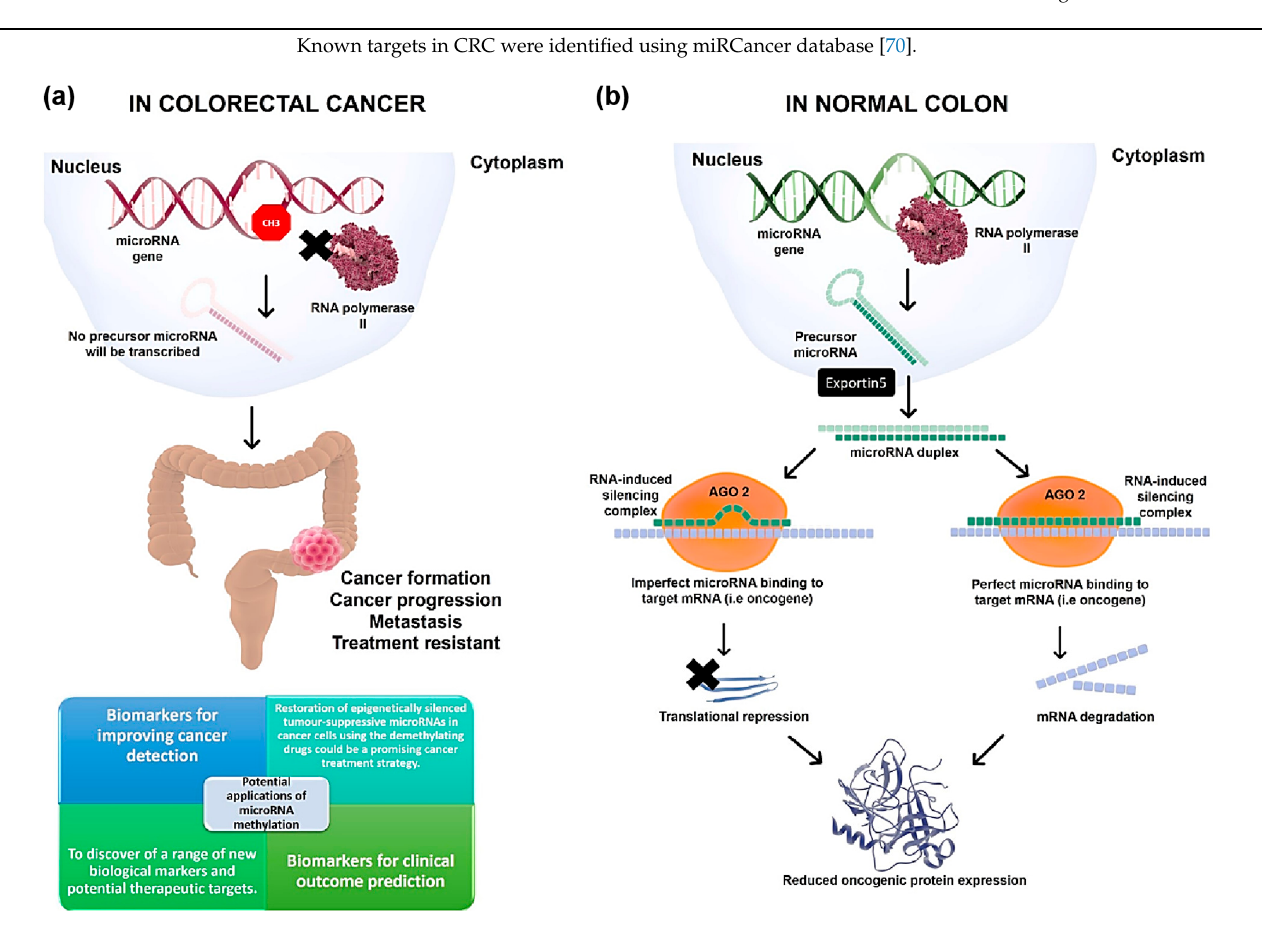
Figure 2. The involvement of methylated microRNA in CRC. ( a ) Simplified illustration of microRNA and its potential involvement in CRC. DNA methylation is a key epigenetic mechanism for silencing RNA polymerase II-transcribed genes [71]. When the microRNA gene is methylated, no precursor microRNA will be transcribed, thus reducing its mature microRNA expression [72]. This in turn could lead to cancer formation, progression, and treatment resistance. ( b ) Simplified illustration of microRNA and its potential involvement and application in normal colon. The unmethylated microRNA gene will lead to transcription of microRNA precursor by RNA polymerase II, which will then be exported into the cytoplasm by Exportin 5, followed by processing with the RISC, which will result in target gene translation repression or mRNA degradation. As a result, oncogenic protein expression will be